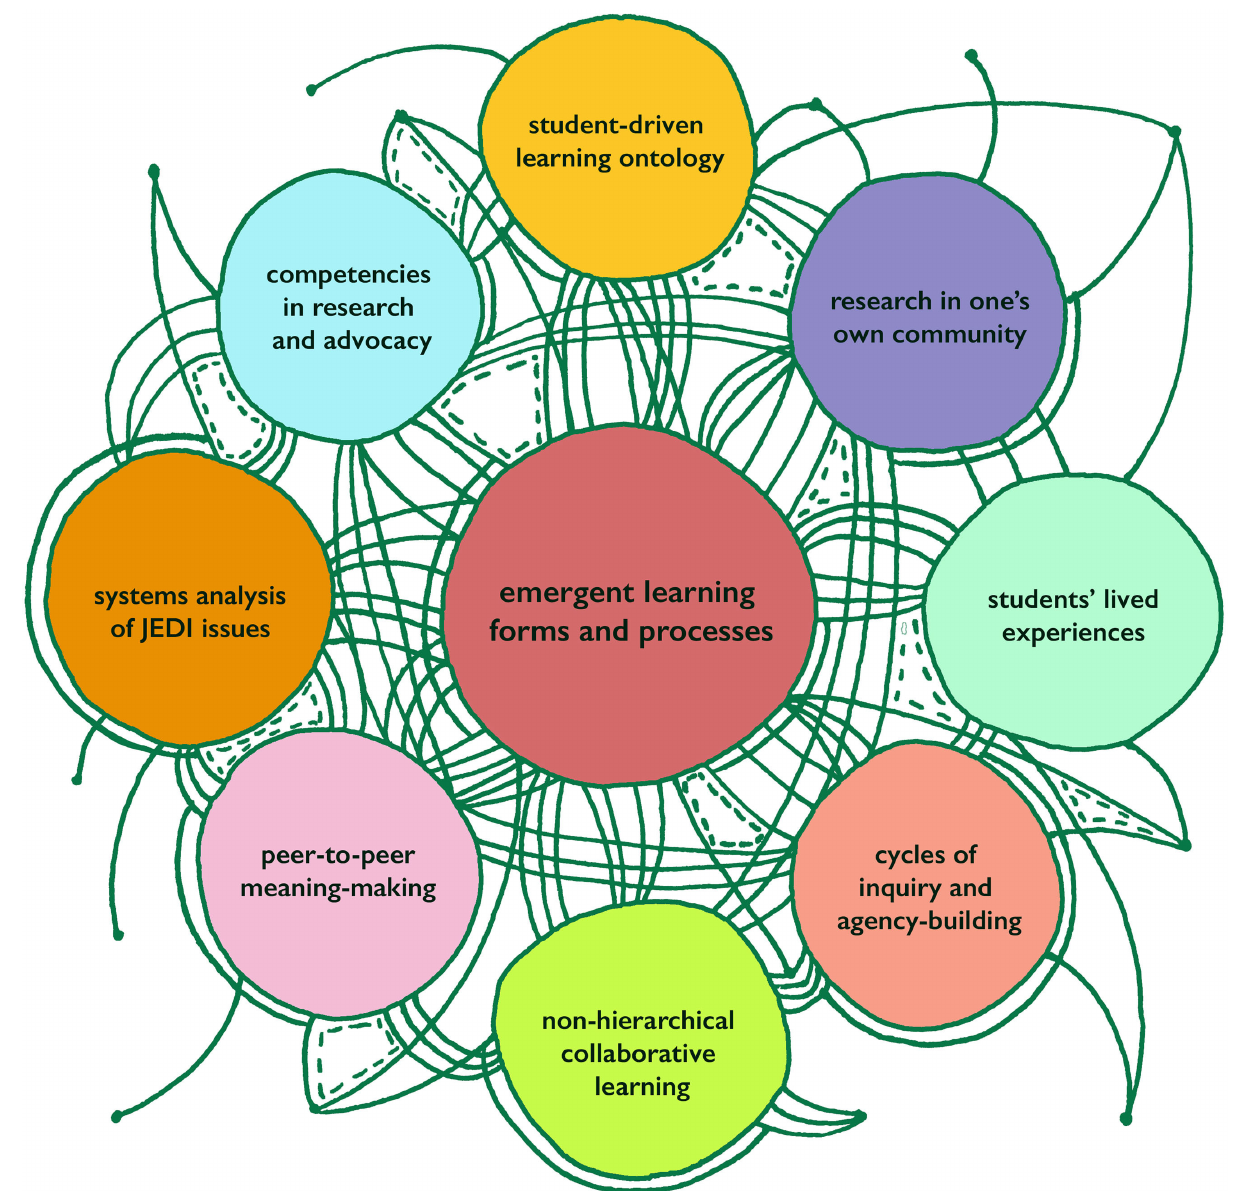
FIGURE 3 | Emergent learning forms and processes. Illustration by Rosalie Zdzienicka Fanshel. This diagram demonstrates the forms and processes of learning we identified as emerging in foodscape mapping work. See Table 3 for details of corresponding themes.